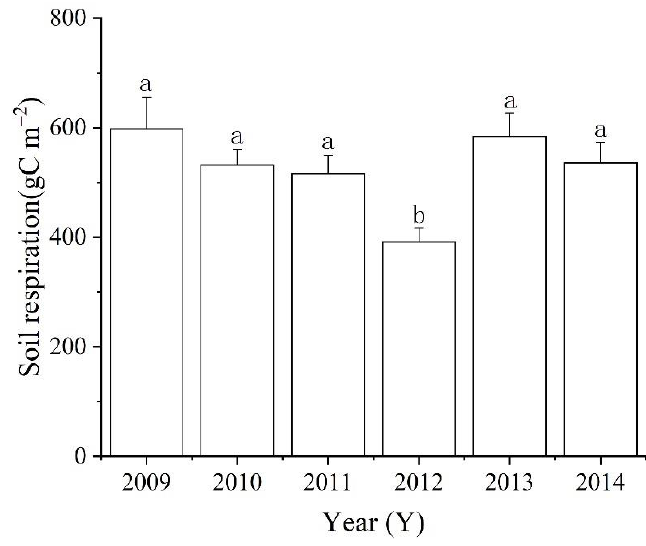
Figure 4. Dynamics in annual soil respiration across study years.